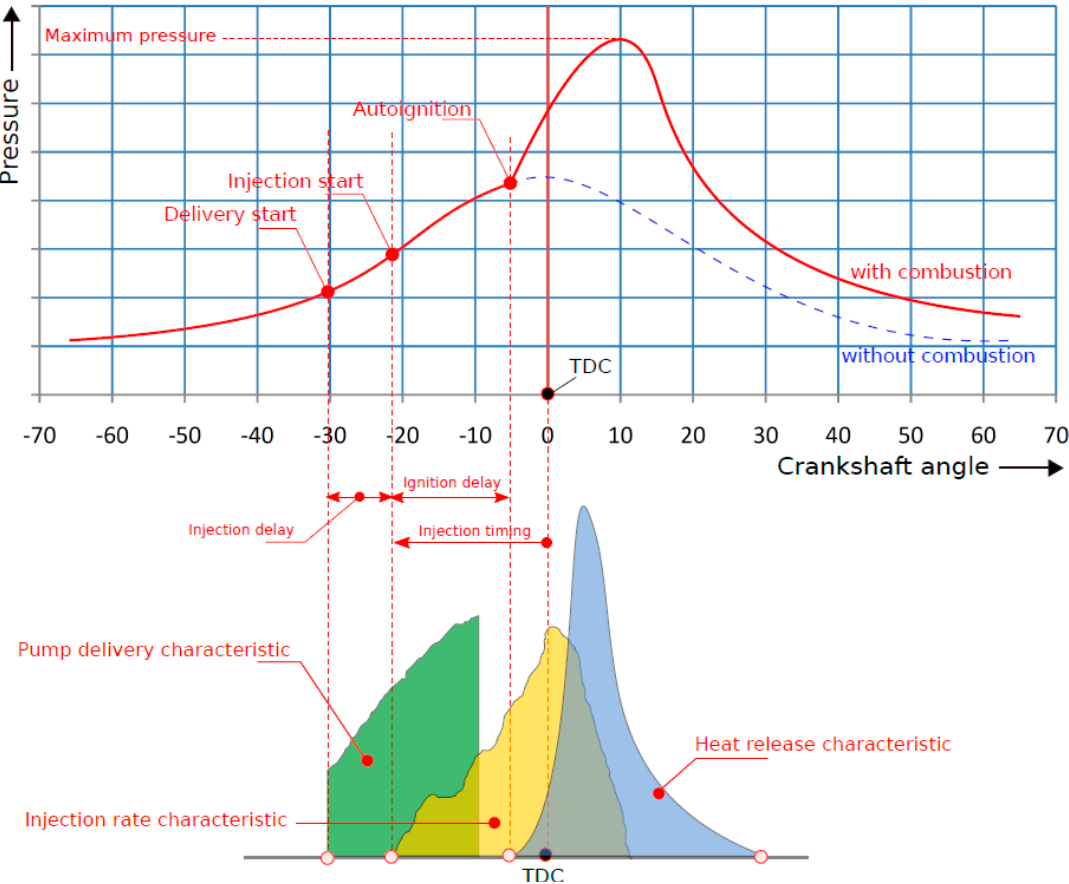
Figure 6 . Cylinder pressure, pump delivery, injection rate and heat release rate curves in a typical CI internal combustion engine.